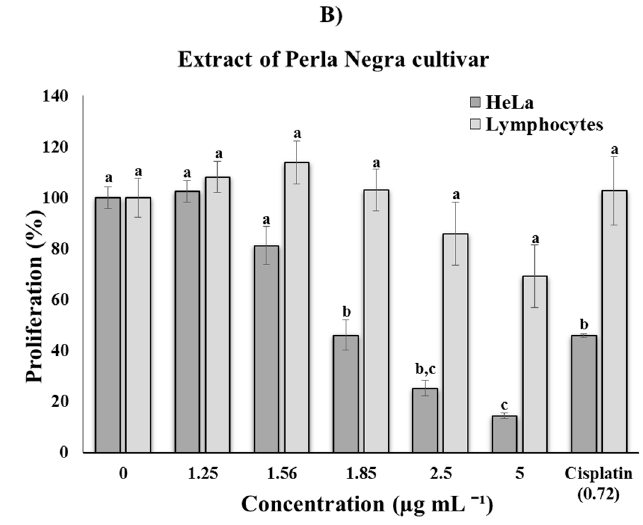
Figure 1. Proliferation assay. ( A ) Inhibitory effect of amarus silvestrys on HeLa cells; ( B ) HeLa cells and lymphocytes with the Perla Negra methanolic extract at different concentrations (0 µg·mL − 1 , 1.25 µg·mL − 1 , 1.56 µg·mL − 1 , 1.85 µg·mL − 1 , 2.5 µg·mL − 1 , and 5 µg·mL − 1 ) and Cisplatin (0.72 µg·mL − 1 ) for 72